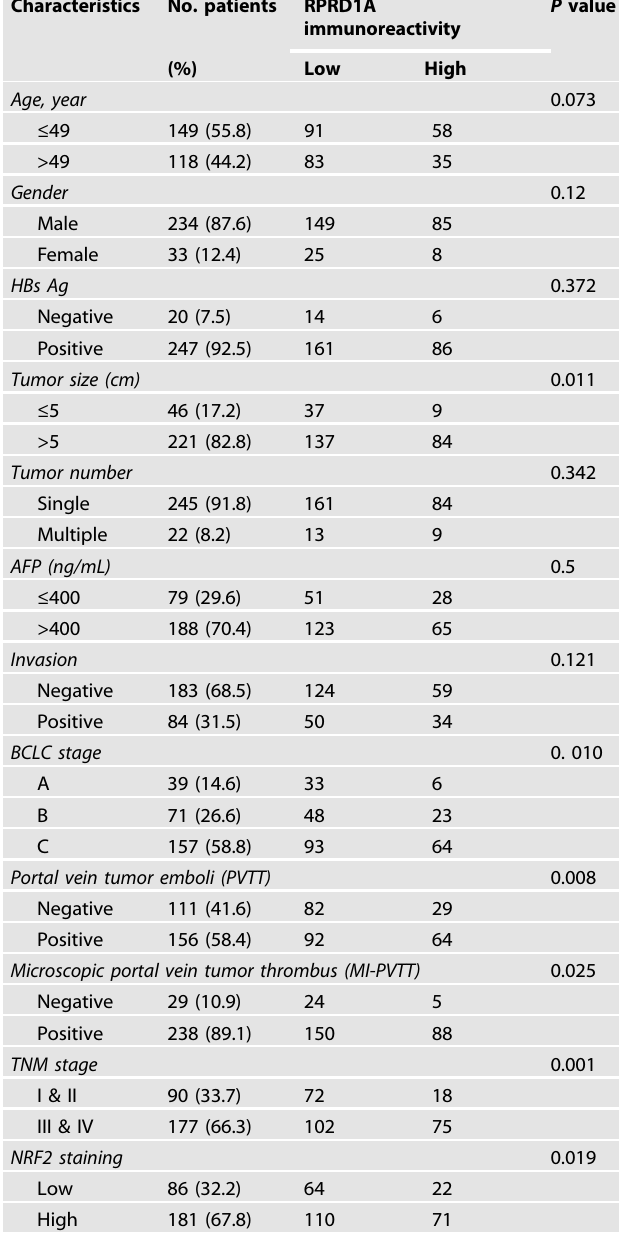
RPRD1A competitively binds to TRIM21 to decrease the p62 ubiquitination and NRF2 degradation To investigate the mechanism of RPRD1A on stabilizing NRF2 and p62 protein, the immunoprecipitation by RPRD1A antibody from